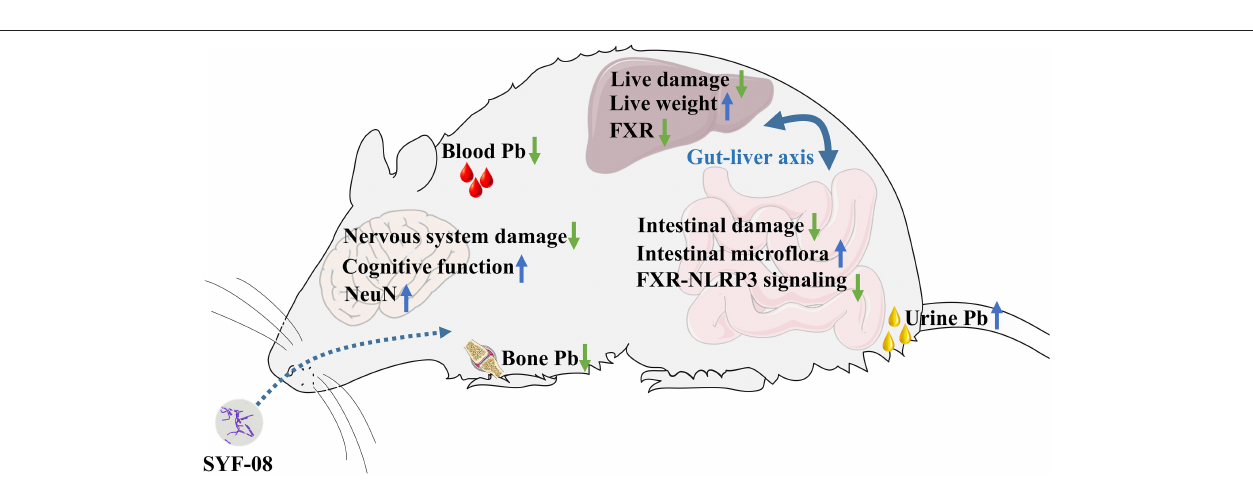
FIGURE 8 | The summary of the